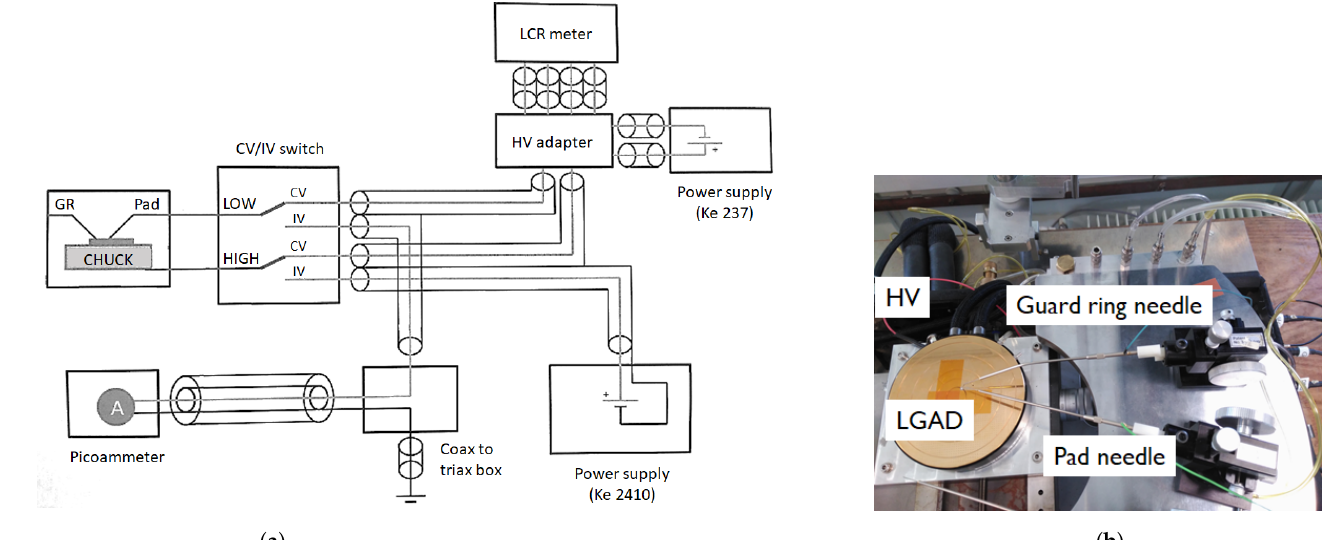
Figure 3. ( a ) I-V/C-V diagram and ( b ) picture of the probe station setup in the Solid State Detectors (SSD) laboratory at